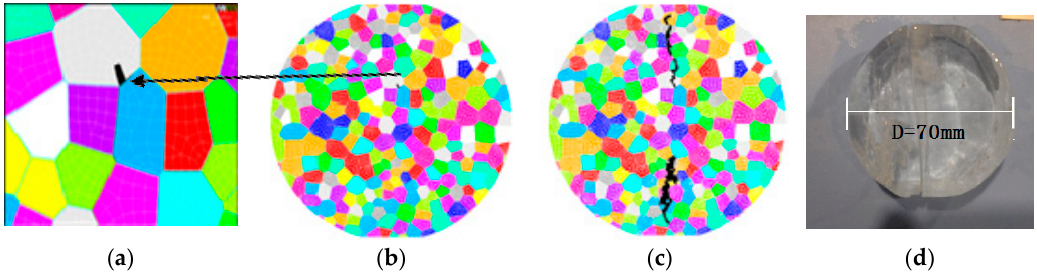
Figure 4. Crack failure process of river ice by numerical simulation: ( a ) local amplification of initiation crack; ( b ) cracking appears; ( c ) final failure mode; ( d ) failure form of physical test.